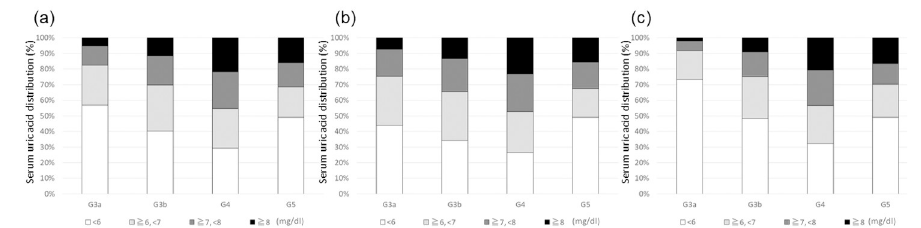
Fig 2. Serum uric acid distribution according to G category. (a) All participants; (b) Men; and (c) Women.